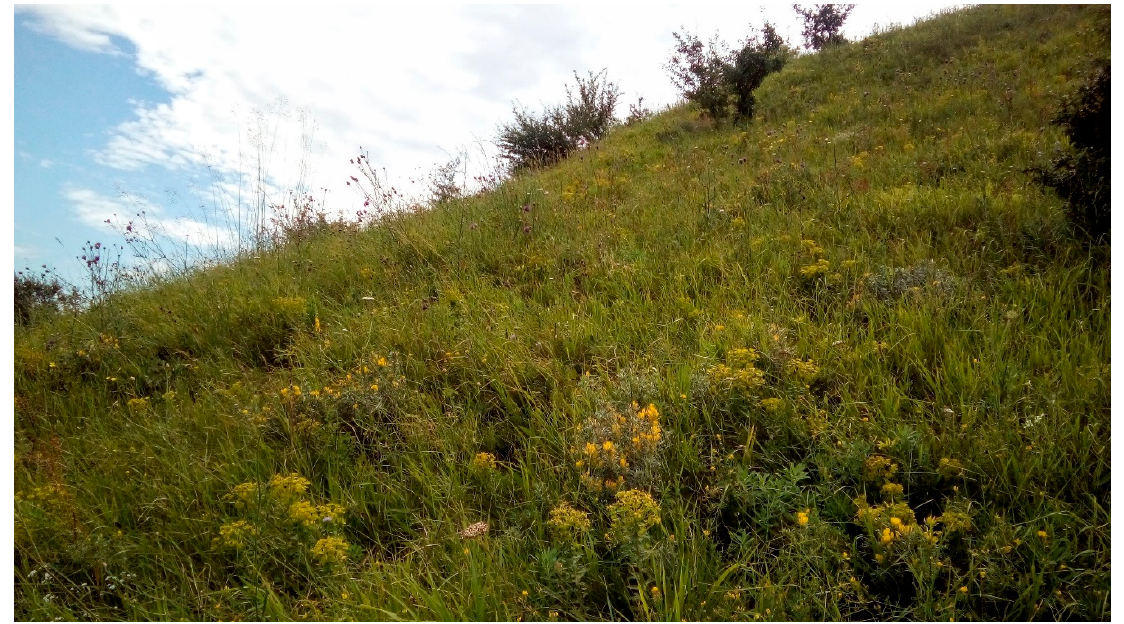
Figure 7. View of the high diversity steppe grassland on loess with Euphorbia pannonica and Chamae- cytisus austriacus in the foreground on 8 July 2019. (Photo: T. Kalapos).